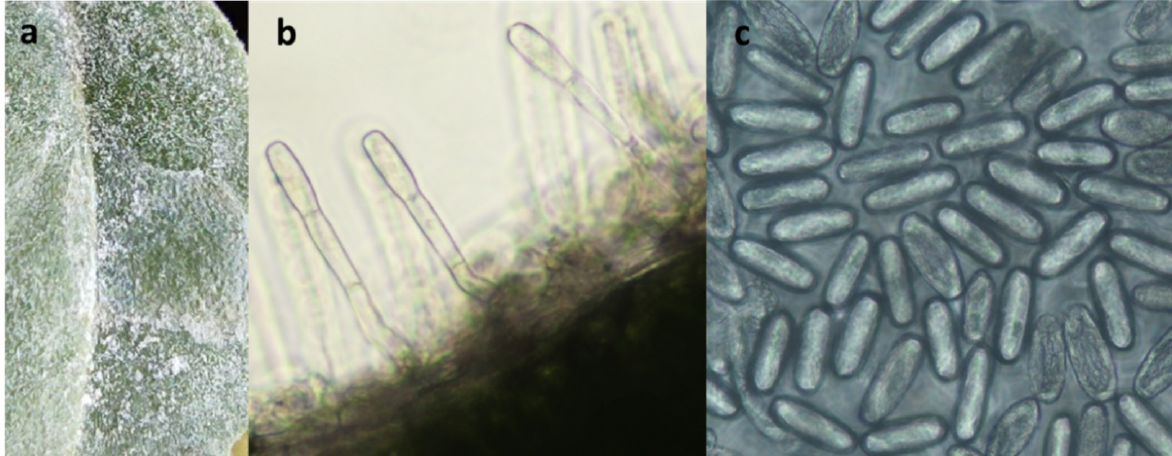
Figure 4. Particular of powdery mildew on a Diplotaxis tenuifolia leaf ( a ). Conidiophores ( b ) and conidia ( c ) of Erysiphe cruciferarum viewed with a light microscope.